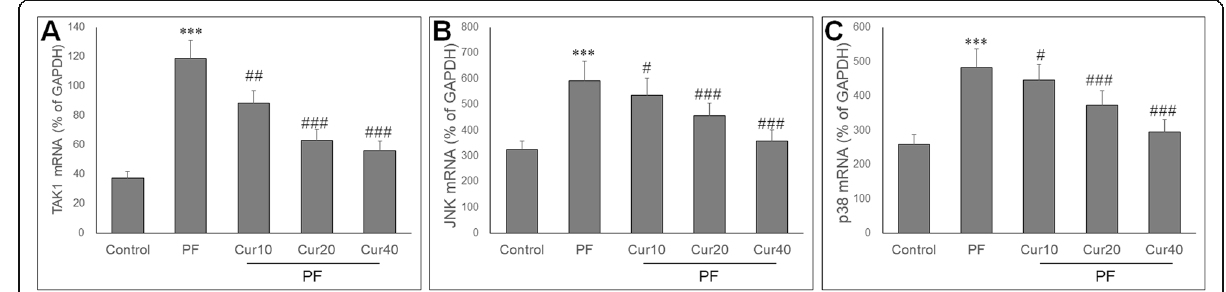
Fig. 6 Effect of curcumin on mRNA expressions of TAK1, JNK and p38 in PF rats. qRT PCR showed that after induction of PF, the mRNA levels of